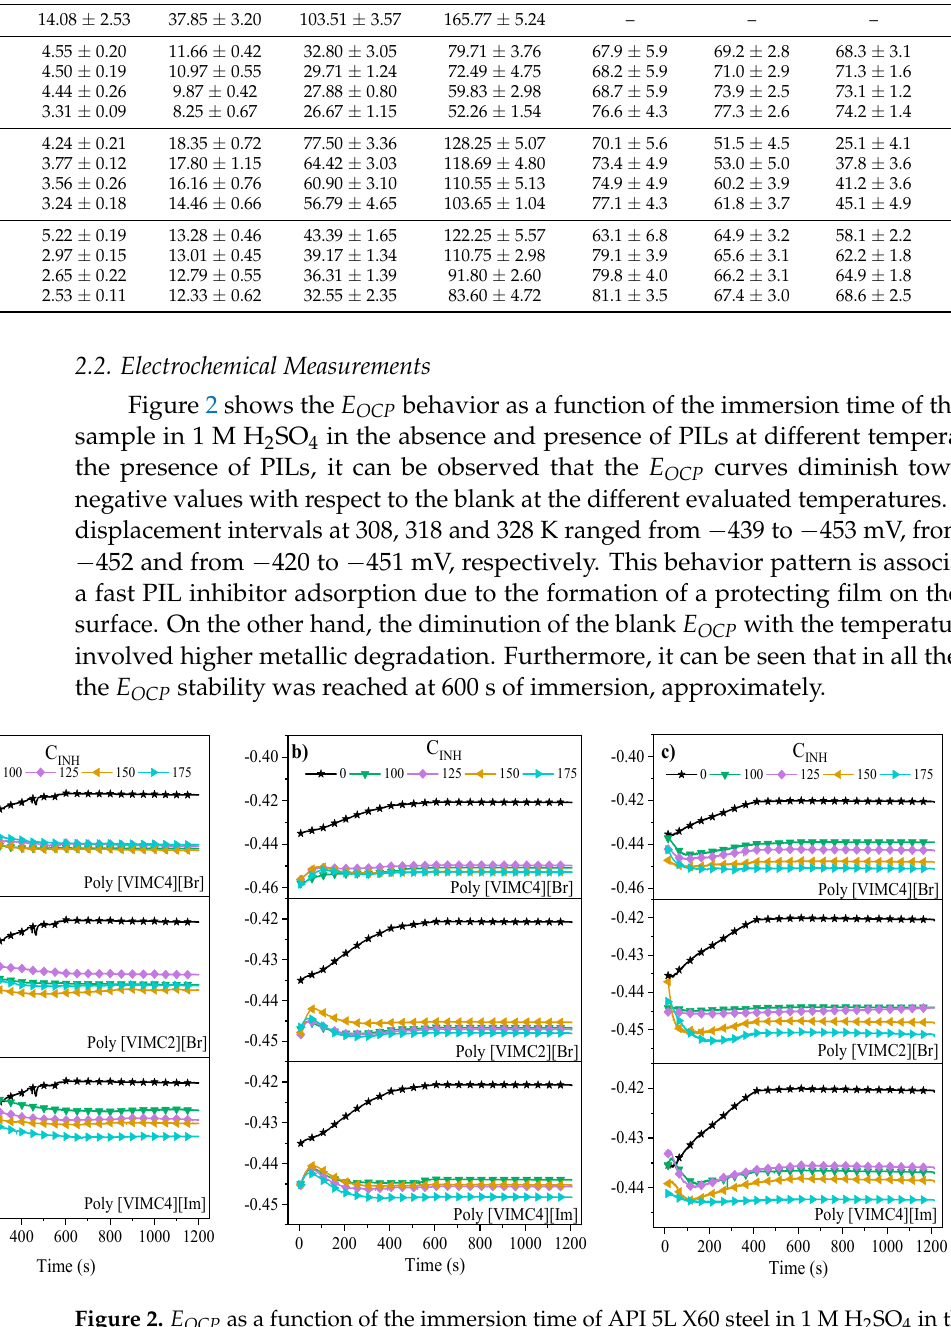
Table 2. V corr of API 5L X60 steel in 1 M H 2 SO 4 with and without CIs by weight loss.